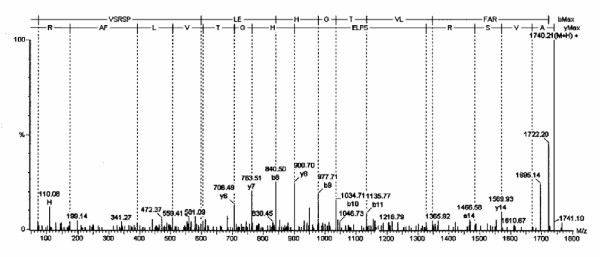
The tandem mass spectrum is shown for the neuroglobin amino acid 15 to 30 peptide.